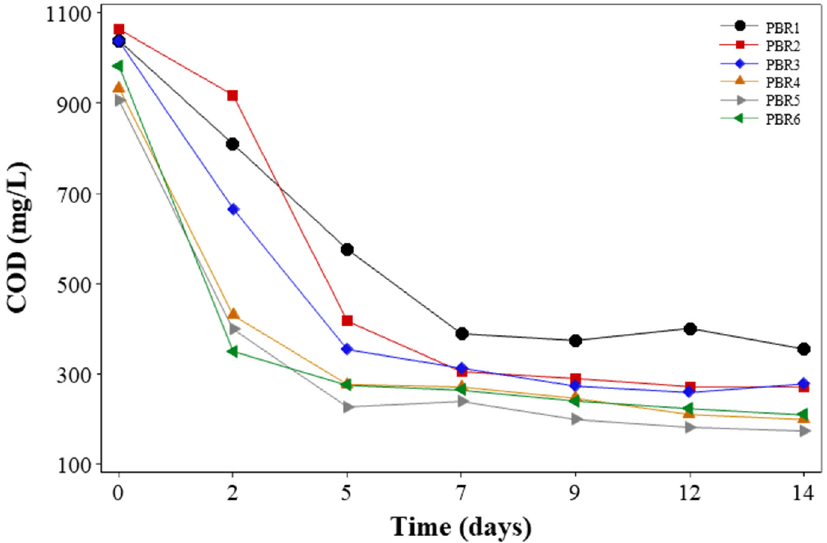
Figure 3. Variation of soluble COD concentrations in PBR effluents .